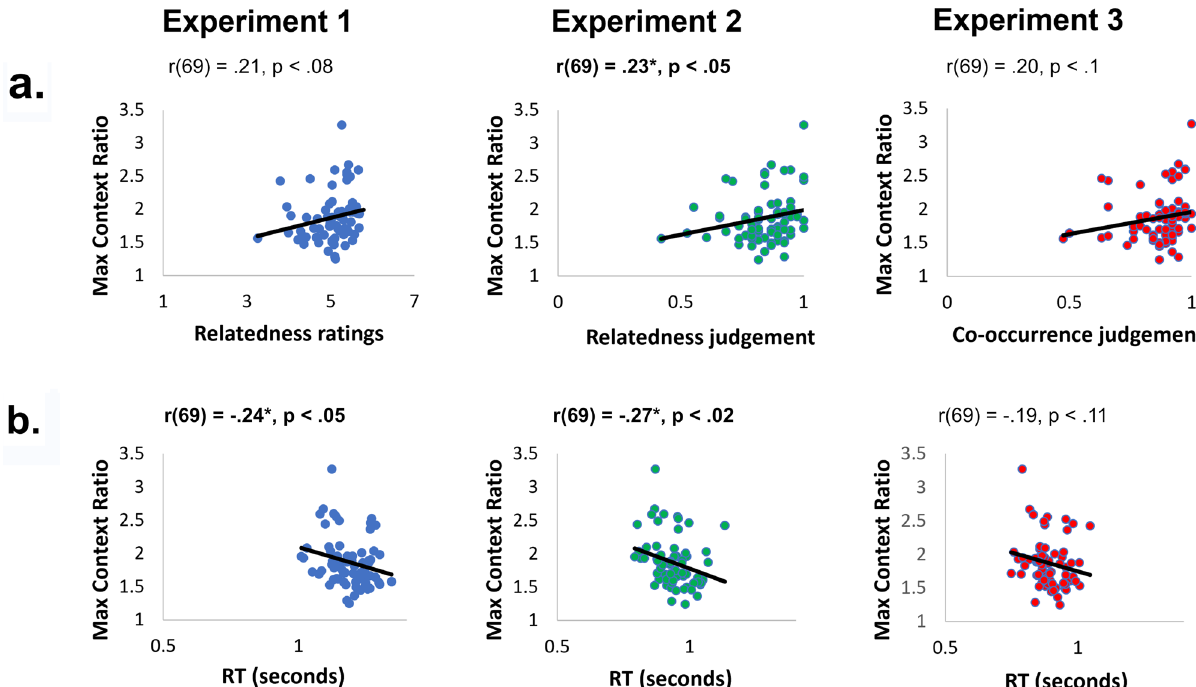
Figure 3. Correlations between the representation of context in VGG16 and contextual performance in humans. (a ) Positive correlations between human ratings of contextual relatedness and context similarity in the CNN; significant in Experiment 2, marginal correlation in Experiment 1 & 3. ( b) Negative correlations between human reaction time and context similarity in the CNN; significant in Experiment 1 & 2. Correlations are computed over 71